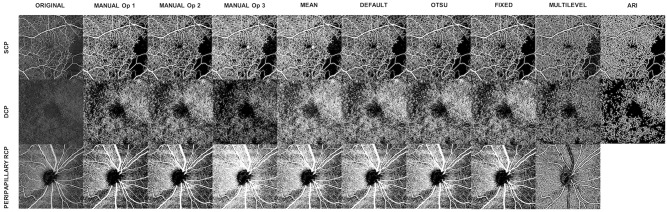
Example of en face angiograms and their binarization with the tested algorithms.Columns and rows show methods and segmented plexuses, respectively.